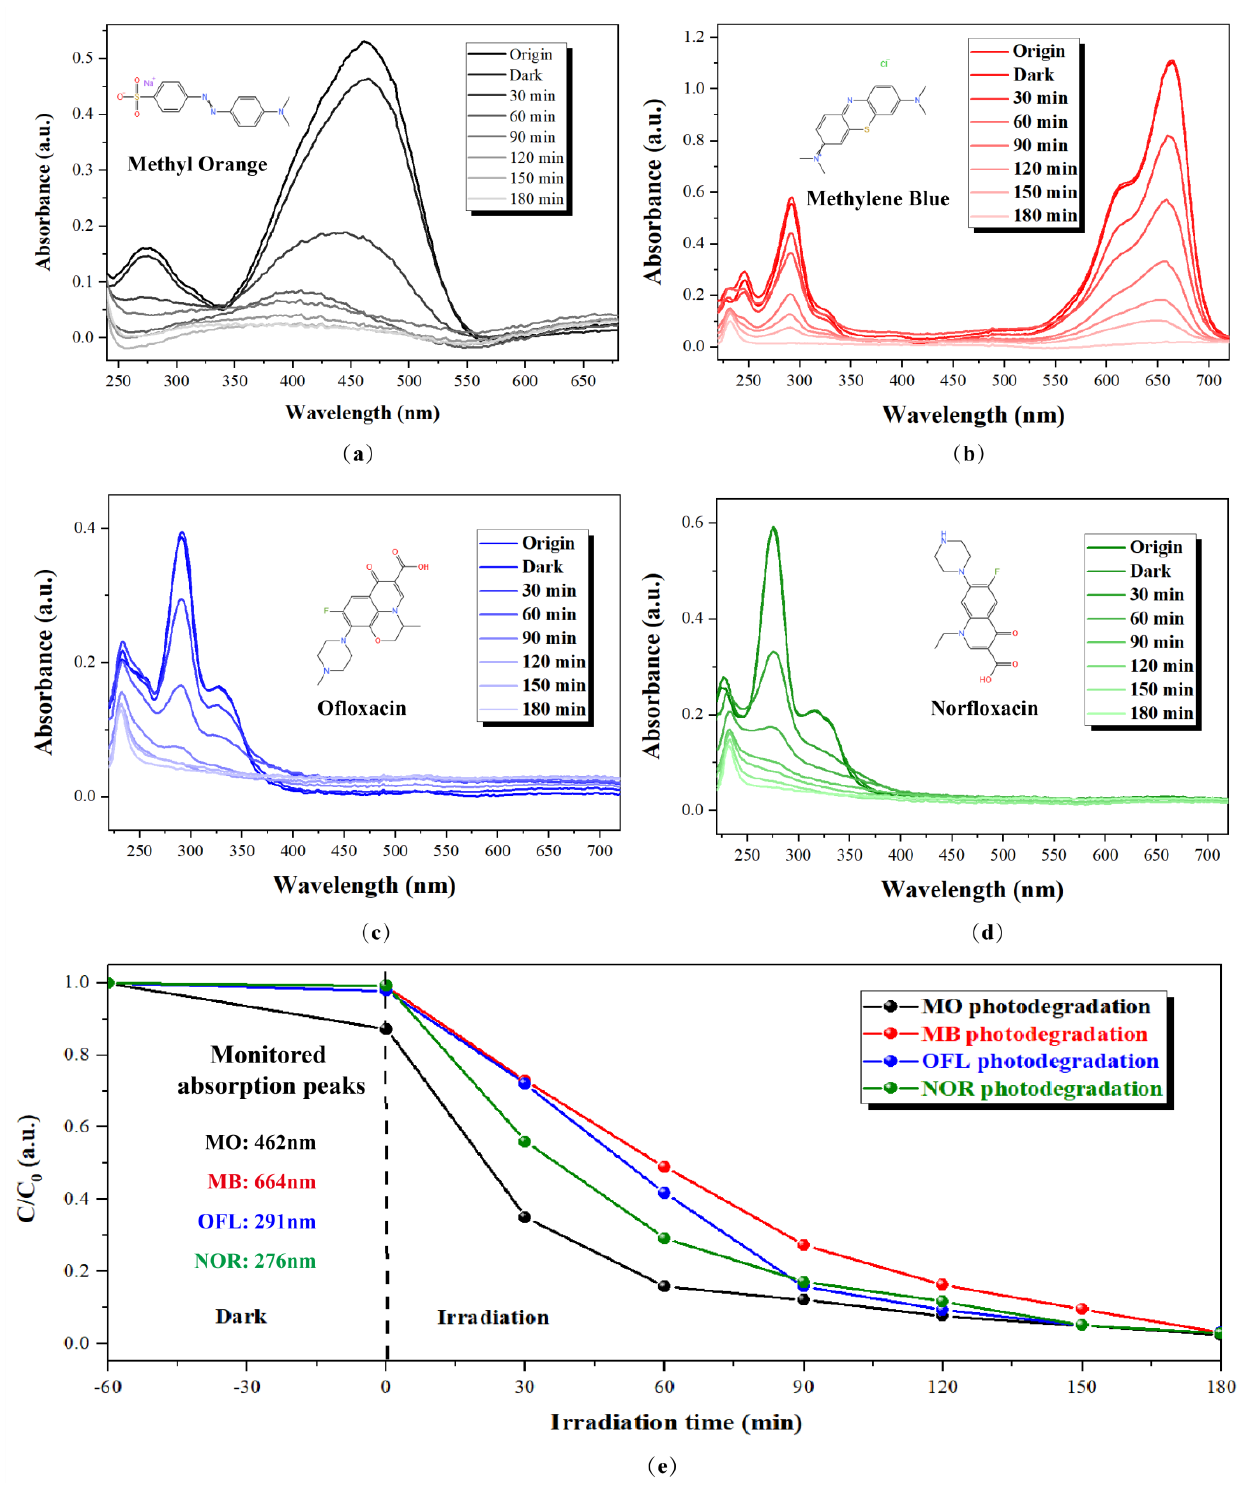
Figure 7. Changes in the UV-Vis absorption spectrum of photodegraded various pollutants with supported nanosheet arrays grown at 110 °C as a function of irradiation time ( a ) MO ( b ) MB ( c ) OFL ( d ) NOR, and ( e ) Pollutants concentration changes as a function of irradiation time.